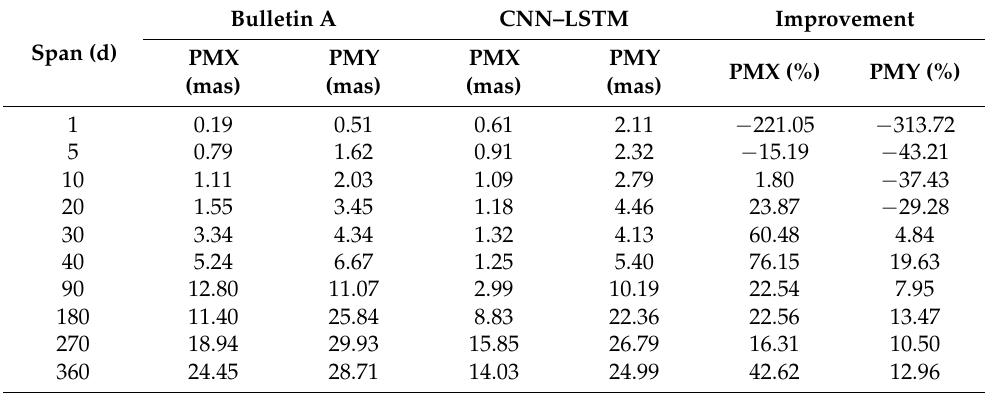
Table 6. Comparison of MAE for polar motion prediction based on two schemes. Hybrid CNN–LSTM model statistics represent the accuracy of the 12-year base time series.